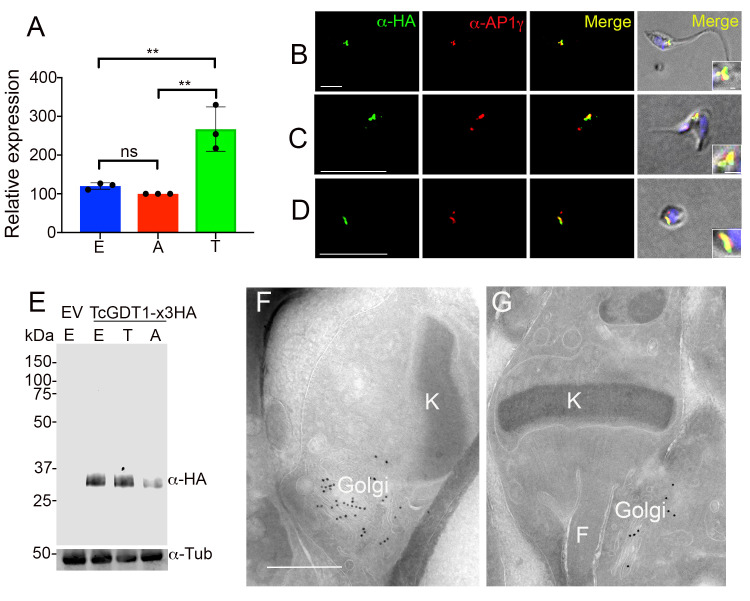
Expression and localization of TcGDT1.(A) Quantitative RT-PCR to determine expression of TcGDT1 in epimastigotes (E), amastigotes (A) and trypomastigotes (T). Level of expression was normalized to TcGAPDH expression. Values are means ± s.d. of n = 3, **p < 0.01, ns = no significant. Statistical analyses were performed using one-way ANOVA and Turkey’s multiple comparisons test. (B-D) Immunofluorescence analysis (IFA) showed co-localization between TcGDT1-3xHA (green) and AP1-gamma (Golgi apparatus, red) in the merged image (yellow) in epimastigotes (Pearsons’ correlation coefficient (PCC) = 0.75 ± 0.05) (B), trypomastigotes (PCC = 0.77 ± 0.008) (C), and amastigotes (PCC = 0.66 ± 0.08) (D). Bars = 5 μm. Insets in differential interference contrast (DIC) images show the colocalization at higher magnification. Bars = 0.5 μm. (E) TcGDT1-3xHA overexpression was confirmed by western blot analysis using anti-HA monoclonal antibodies, using pTREX empty vector (EV) as control cell line. Tubulin (Tub) was used as loading control. (F-G) Cryo-immunogold electron microscopy of epimastigotes overexpressing TcGDT1-3xHA showing localization in the Golgi complex (Golgi). Bar = 0.5 μm. F, flagellum, K, kinetoplast.